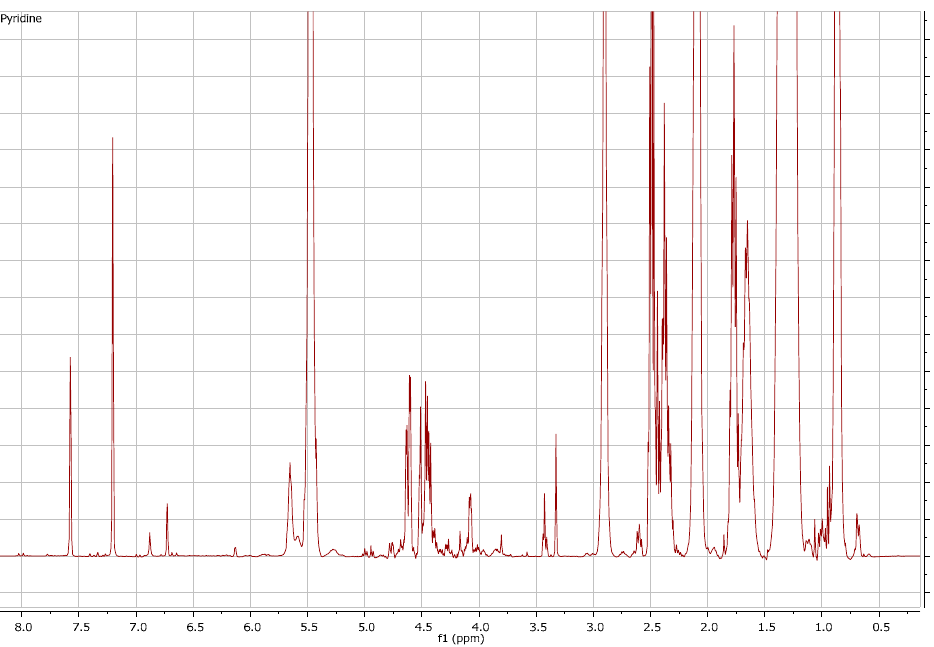
Figure A4. NMR spectrum of flour extract in Pyridine-d5.